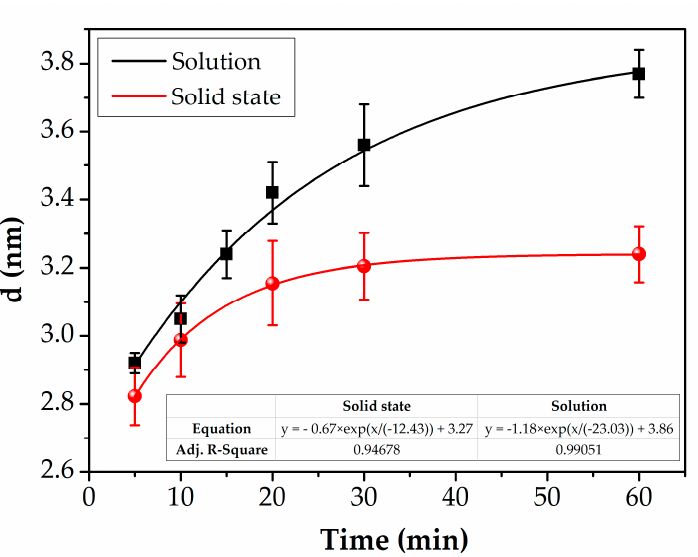
Figure 7. Calculated size of CdTe QDs versus time course both in solid state (red line same curve of Figure 3) and in solution (black line).